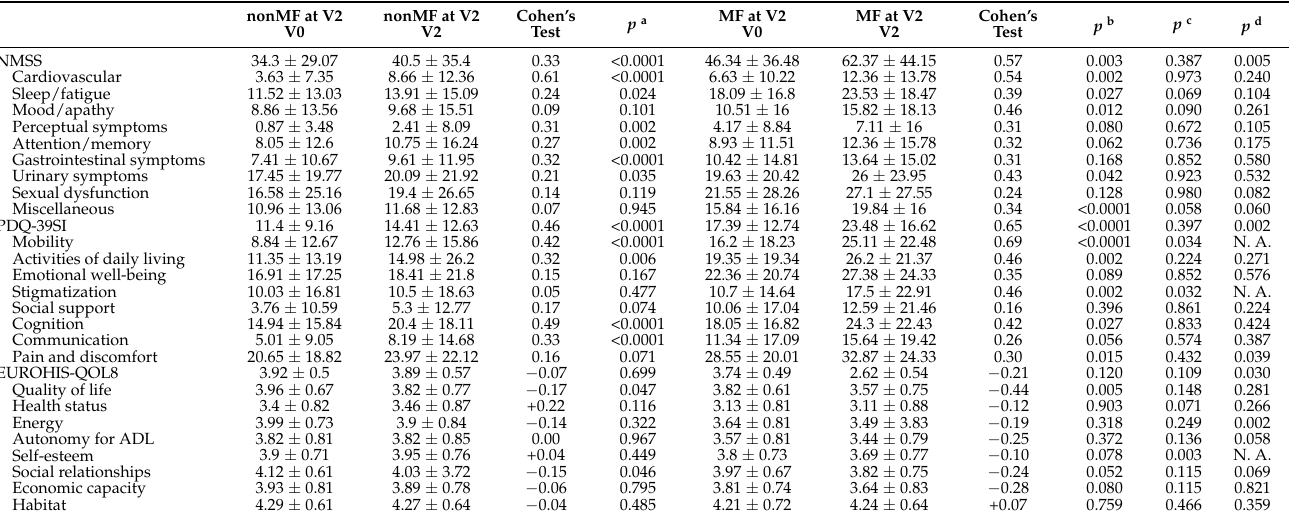
Table 2. Changes in non-motor symptoms and quality of life in PD patients who developed MF at V2 (MF at V2; N = 91) compared with those patients who did not develop MF at V2 (nonMF at V2; N =